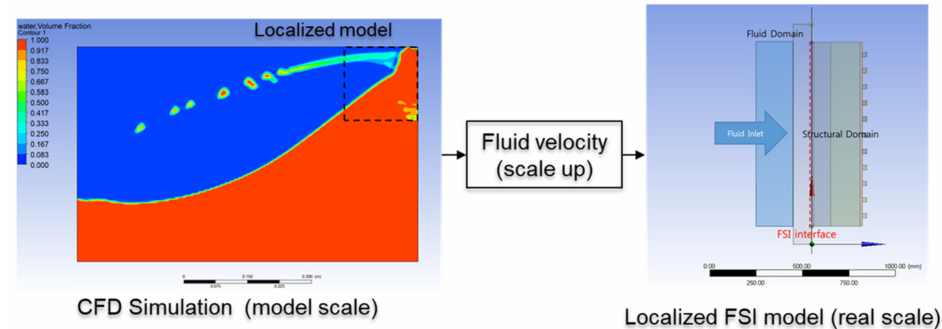
Figure 10. Analysis procedure for structural assessment of